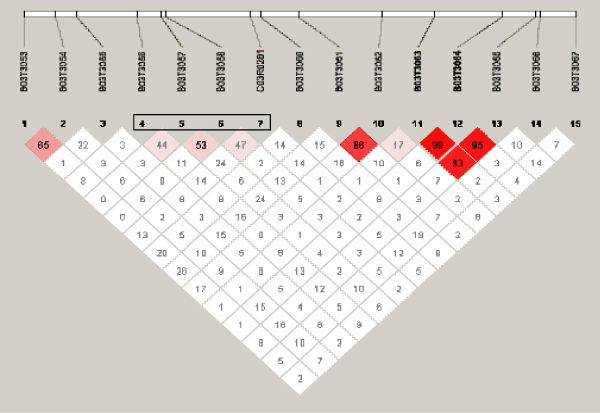
Degree of linkage disequilibrium present within region of interest. Output obtained from HAPLOVIEW assessing the degree of LD present within region. The four SNPs that showed the most significant association (B03T3056, B03T3057, B03T3058, and C03R0281) with the trait are outlined by a black rectangle. Each square represents a pair-wise comparison and the number within the square indicates the D' value. Significant LD is indicated by a red square.